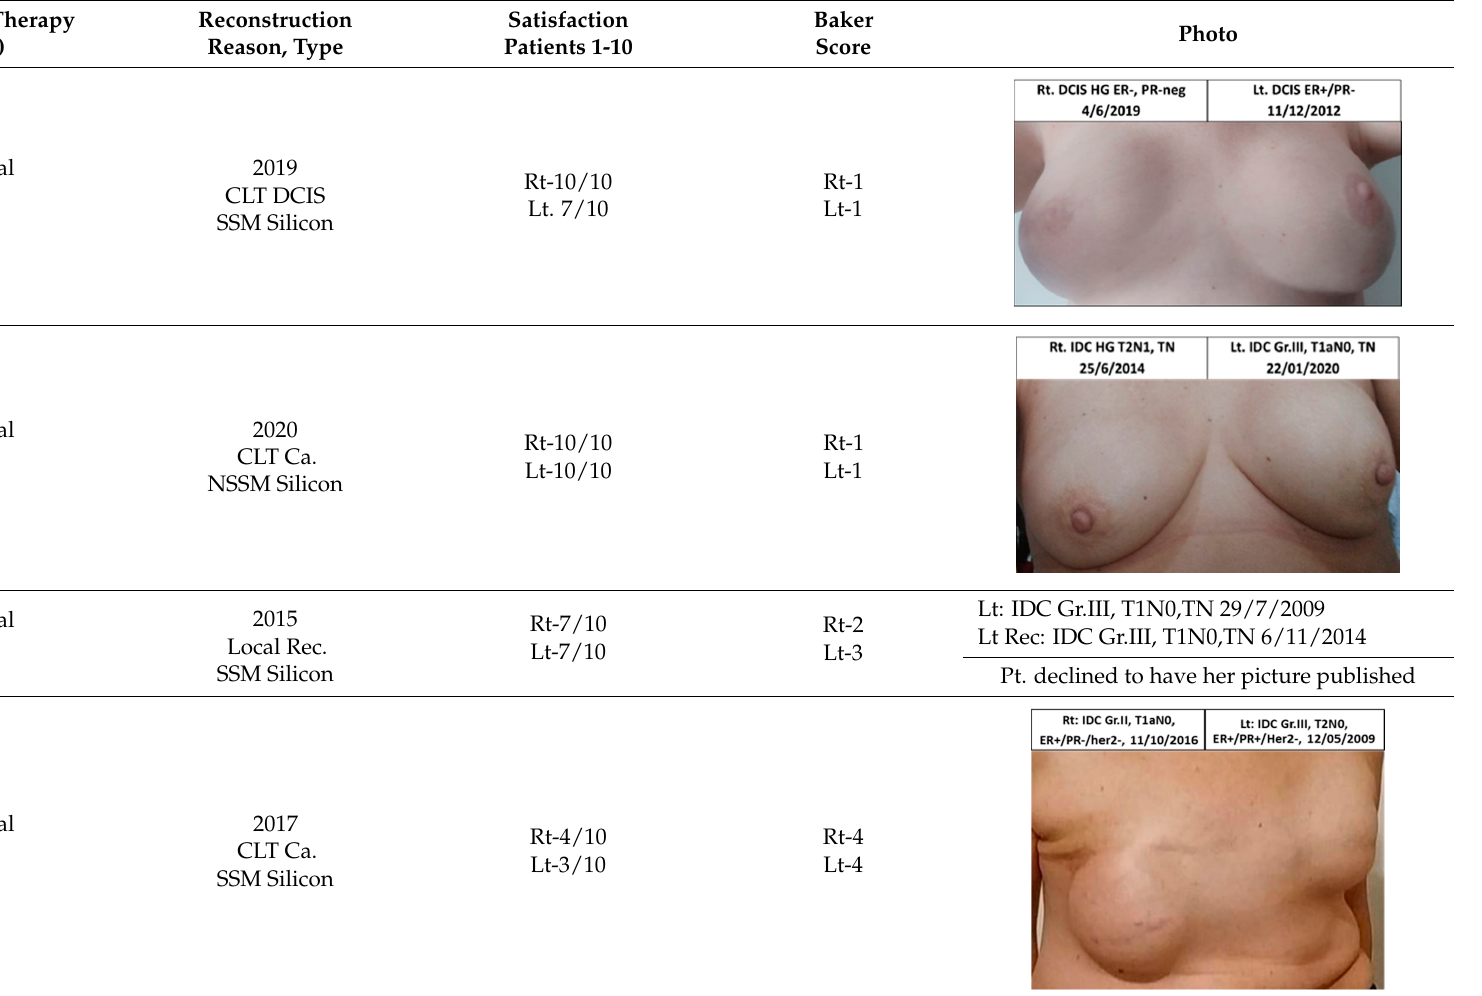
Table 1. Mastectomy and reconstruction after prophylactic breast irradiation.